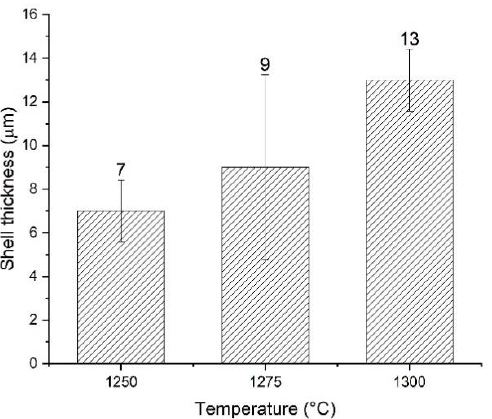
Figure 3. Shell thickness surrounding the IN625 powder after at 1250 °C, 1275 °C and 1300 °C. A greater variation of the thickness was evident from 1275 °C to 1300 °C than from 1250 °C to 1275 °C. This could be justified by the formation of a liquid phase at 1300 °C that enhances the interdiffusion process. No morphological variations were observed be- tween 1250 °C, 1275 °C and 1300 °C, suggesting that the interaction gave rise to the for- mation of the same products. This confirms that the first peak at 1284 °C observed in the DTSC curve of WC–IN625 mixture (Figure 1) refers to local melting of IN625 in contact with WC and not to the formation of different phases at lower temperatures. Liquid phase sintering takes place only in cycle 4, at the highest sintering temperature (1350 °C) where the superalloy is completely melted. In this condition, the microstructure of the interaction region is completely different since the melted superalloy had spread to the surrounding areas (Figure 2f). The concentration profiles of the different elements through the interaction zones be- tween WC and IN625 in the pre-compacted condition and after the four different sintering cycles are shown in Figure 4. Ni, Cr, Mo and Nb are obviously present in the IN625 powder. However, W is pre- sent in the WC particles area. The variation of the Cr, Mo and Nb insider IN625 particles will be analyzed later (Figure 6). Considering the interaction area between IN625 particle and WC carbides, in the pre-compacted condition, the concentration gradients are sharp, indicating that no diffusion phenomena occurred at the WC–IN625 interface. In the 1250 °C sintered specimen, an interdiffusion layer with a thickness of around 8 µm formed, confirming the shell thickness reported in Figure 3. The concentration profiles displayed a continuous and gradual variation of Cr and W elements. In contrast, Mo showed a con- centration peak near the IN625, and Ni drastically decreased with a stepped trend in the interaction area. The Mo amount in the interdiffusion layer was higher than that in the IN625, suggesting the formation of a Mo-rich phase. Increasing the sintering temperature up to 1300 °C, the thickness of the interaction region increased and the concentration peak of Mo near the IN625 particle was confirmed.